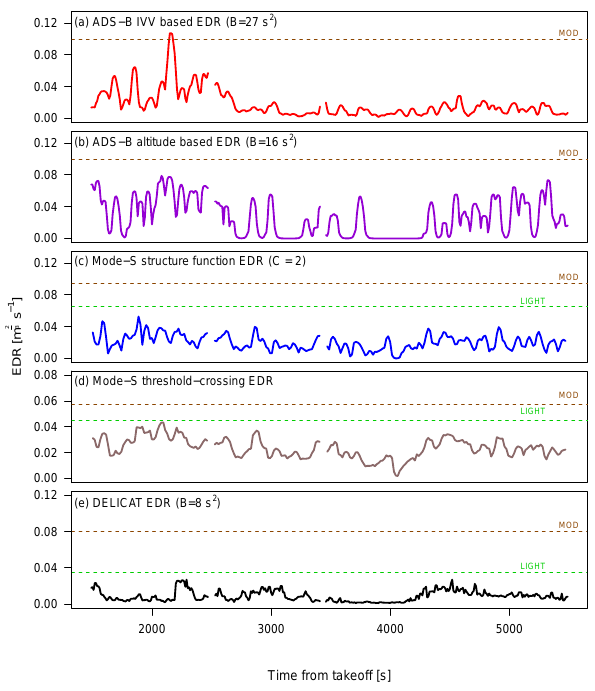
Figure 7. Results for FL8 for all analysed approaches to estimate EDR and a reference EDR (as in Fig. 2). The time series are scaled to match the intensity of the FL9 MOD event. For reference the indicative turbulence levels have been added to the plot. Those are reflecting the FL9 encounters and levels of noise inferred from the calm